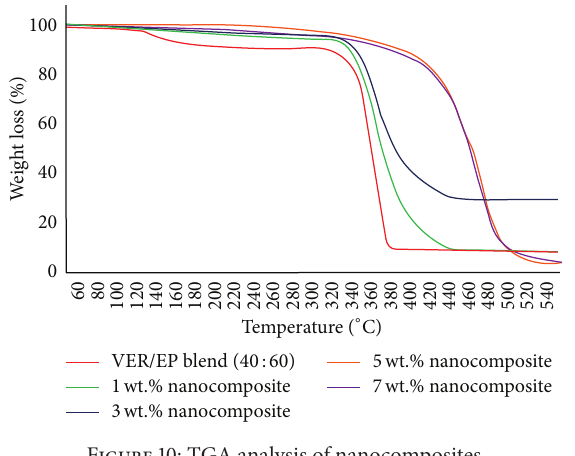
Figure 10: TGA analysis of nanocomposites.